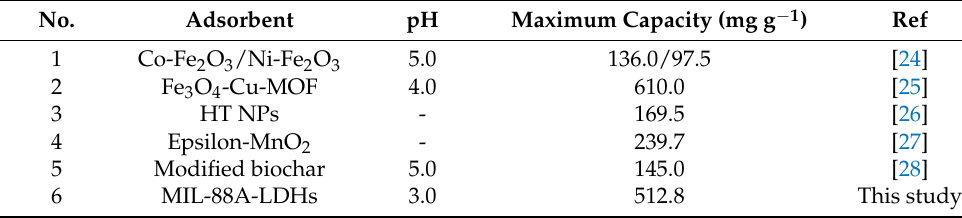
Table 3. Comparison of adsorption capacity of newly reported Pb(II) adsorbents.